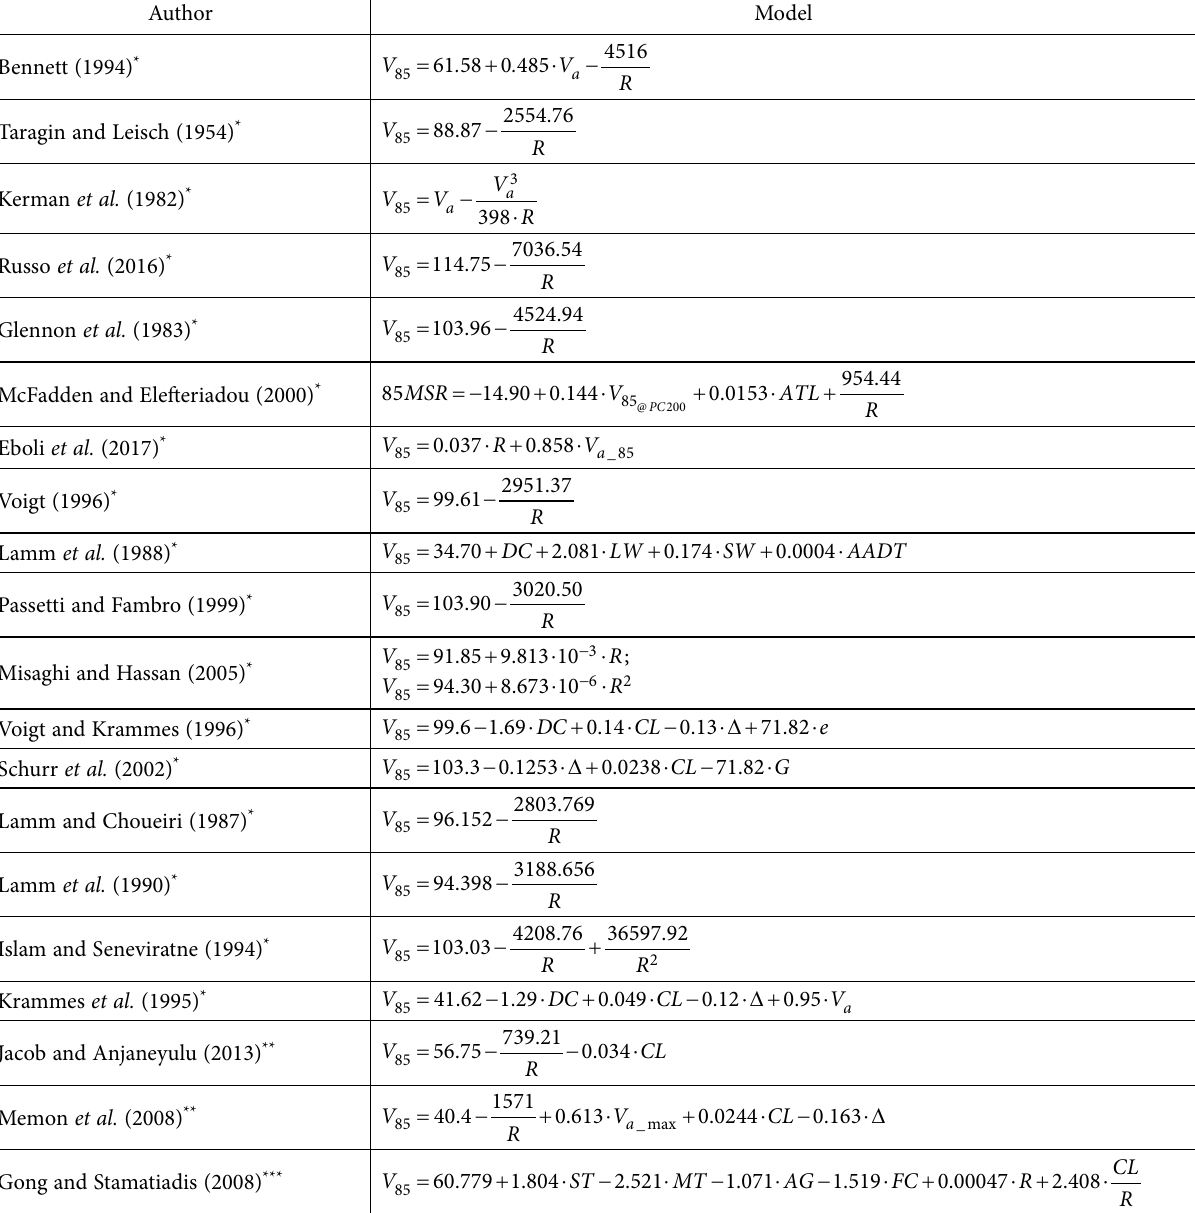
Table 1. V 85 prediction models of horizontal curves for passenger